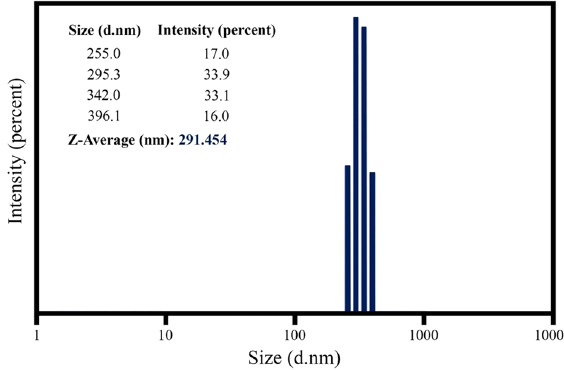
Figure 12. Size distribution of the optimized sample.